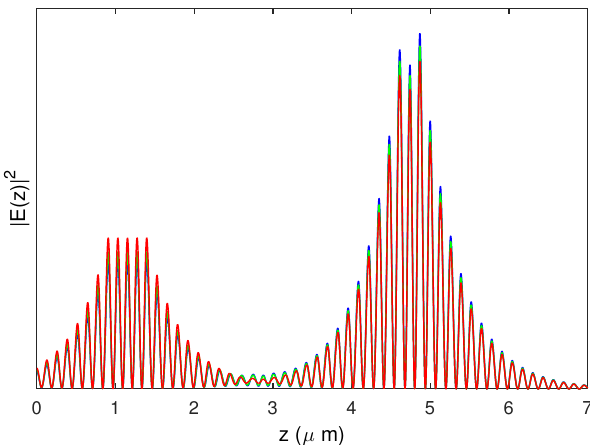
Figure 1. (color online) Optical power distributions along the EAM-VCSEL for d EAM = 0.471 µ m and α EAM = 1000cm − 1 . Blue, green and red curves are for α VCL